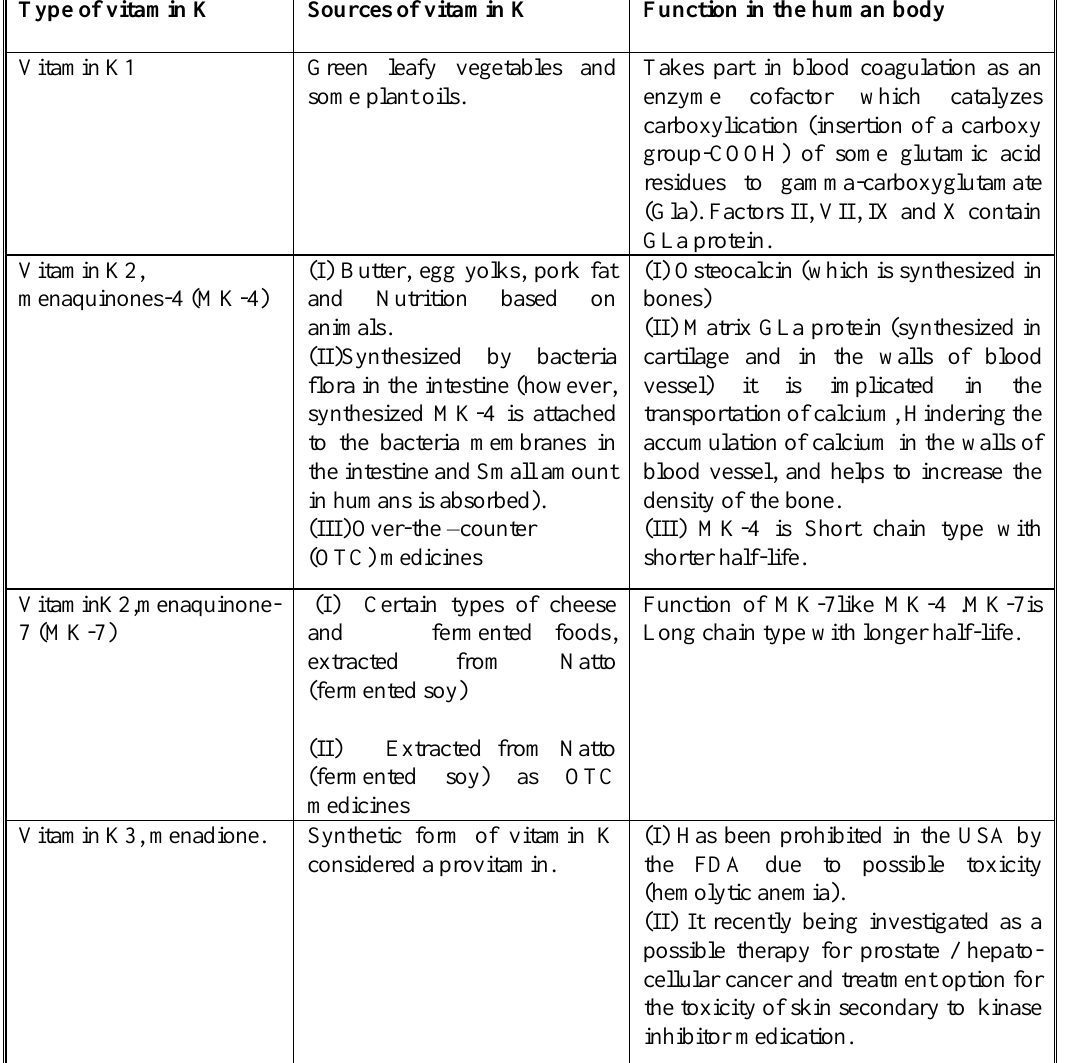
Type of vitamin